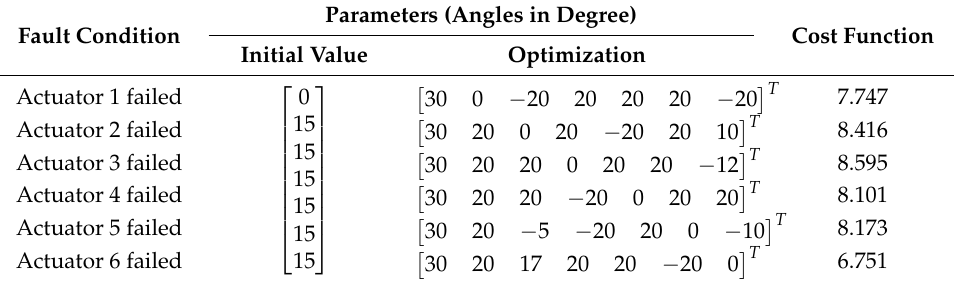
Figure 13. AMS comparison of preliminary configuration with optimized configuration for each actuator failure and prescribed maneuver performance requirement. Table 3. Mission-based parameter optimization results for single actuator failure at a time.